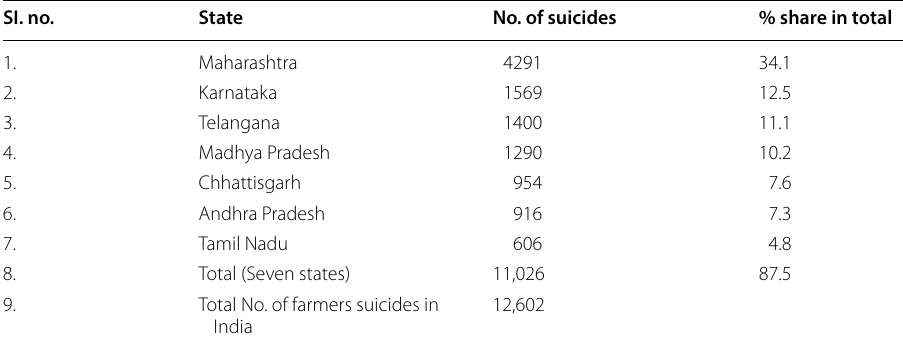
Total number of suicides by farmers in 2015 (12,602) is 2% higher than 2014 (12,360); Maharashtra reported 852 agrarians suicides in the first 4 months of 2017